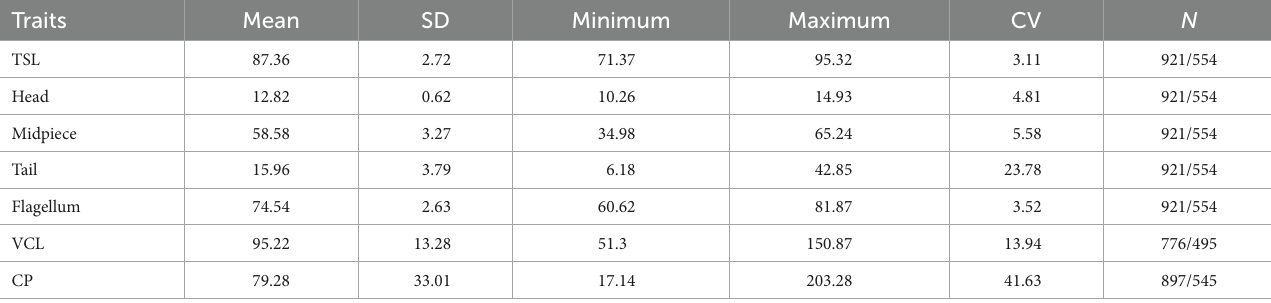
TABLE 1 Descriptive statistics of total sperm length (TSL), head, midpiece, tail and flagellum length, velocity (VCL) and cloacal protuberance (CP) size. Traits